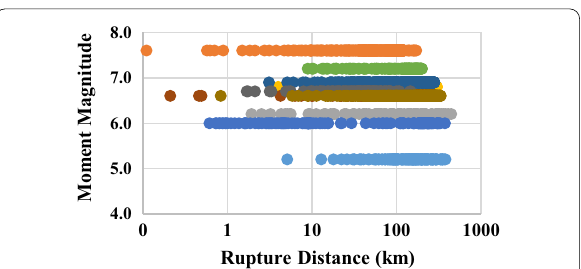
Fig. 1 Magnitude versus rupture distance of selected